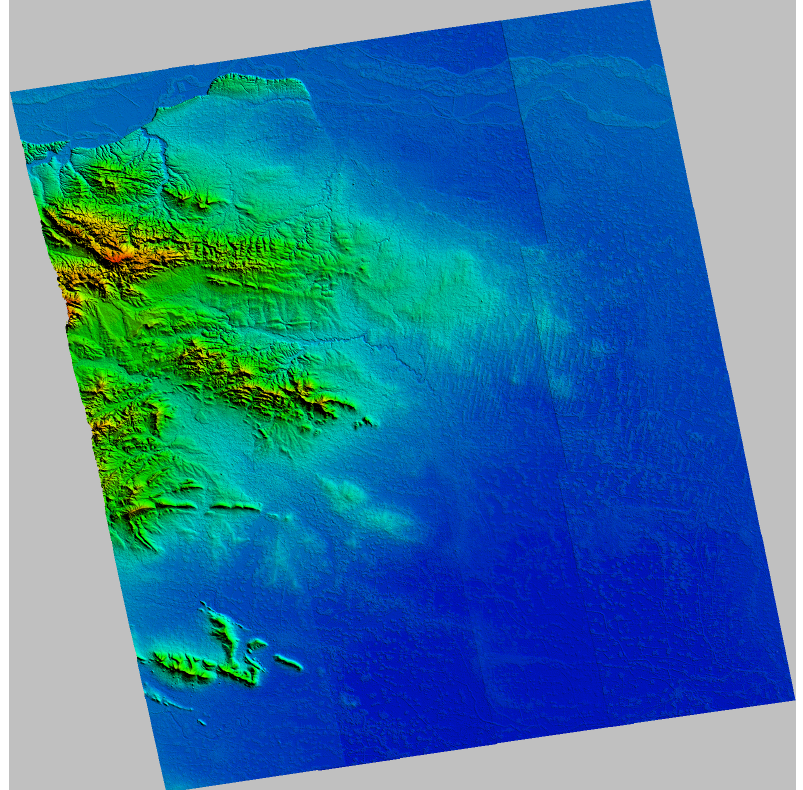
Figure 10. The rendered geocoded map of the generated DEMs; the elevation jumps in the figure are caused by baseline errors.